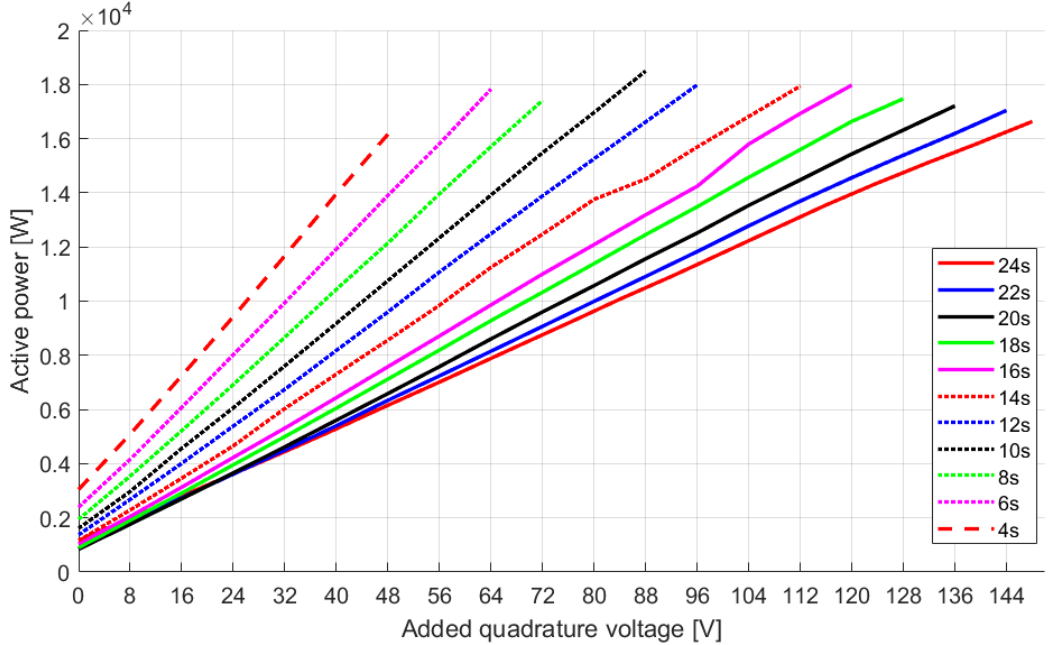
Figure 11. Active power transfer for different line lengths.